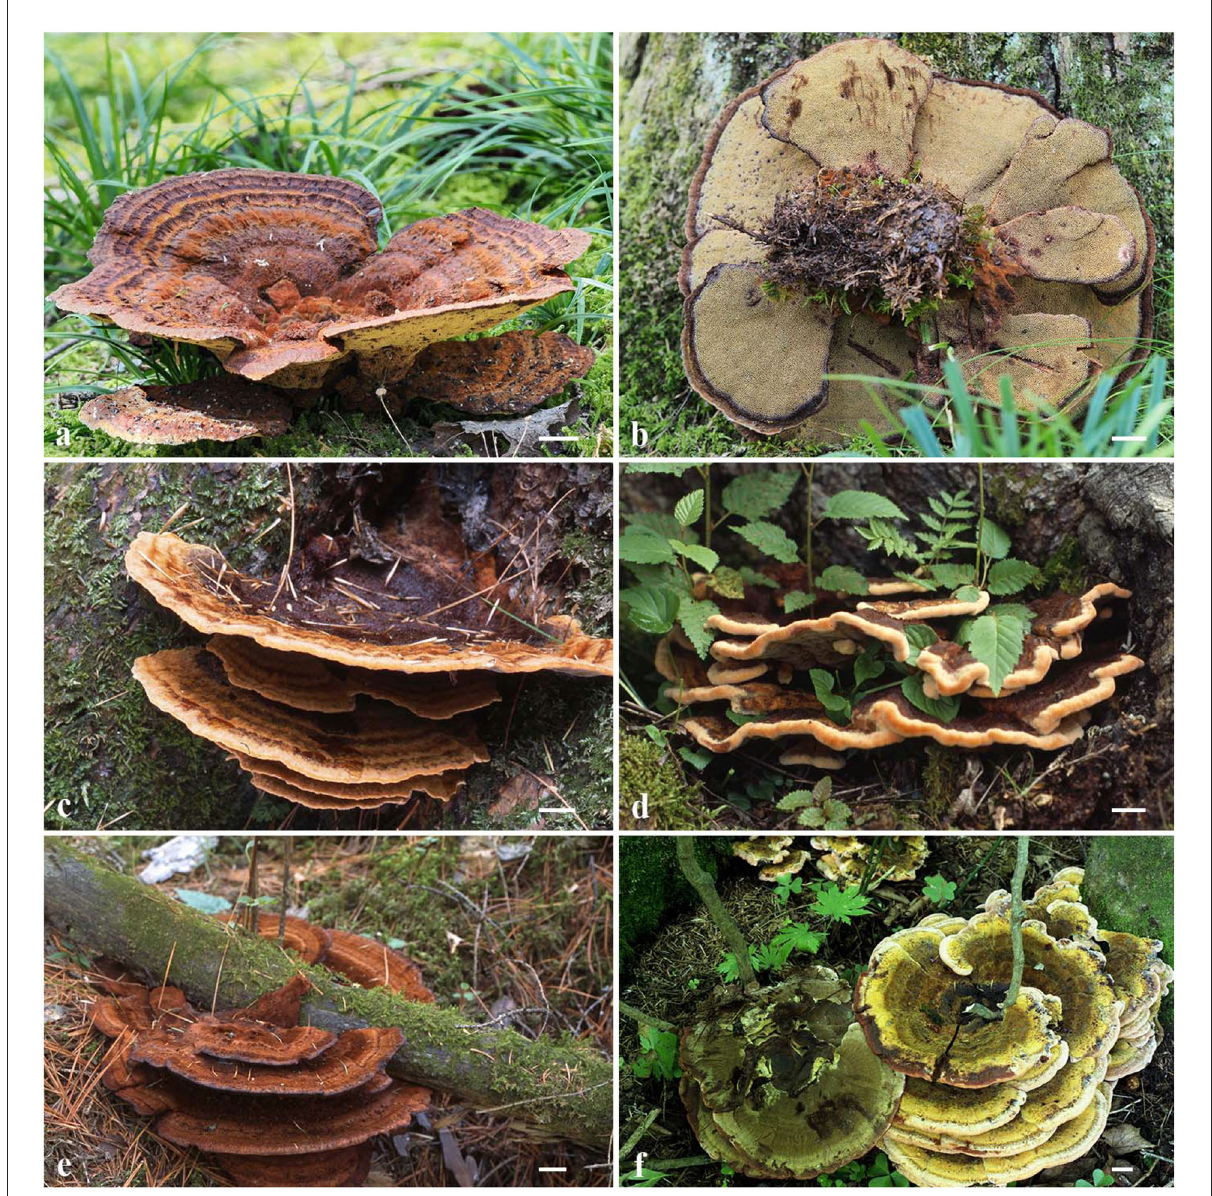
FIGURE2 Basidiocarps of Phaeolus asiae-orientalis. (a,b) Dai 20867 (holotype); (c) Dai 789; (d) Dai 7089; (e) Dai 21784; (f) Dai 14566. Scale bars = 1cm.